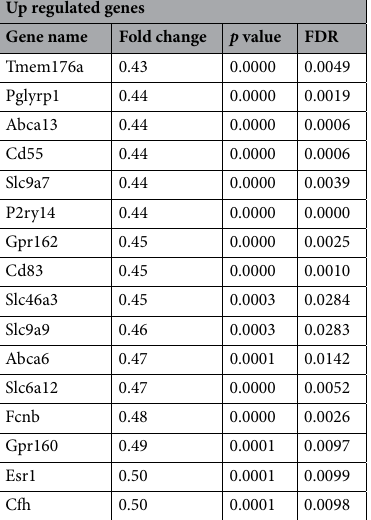
Table 2. Genes differentially regulated by Hdac3 deficiency. RNA from day 3 Hdac3 cKO LysM mice or wild type littermates was collected and used for high-throughput sequencing. Listed genes represent those with two-fold change or greater with an FDR < 0.05.